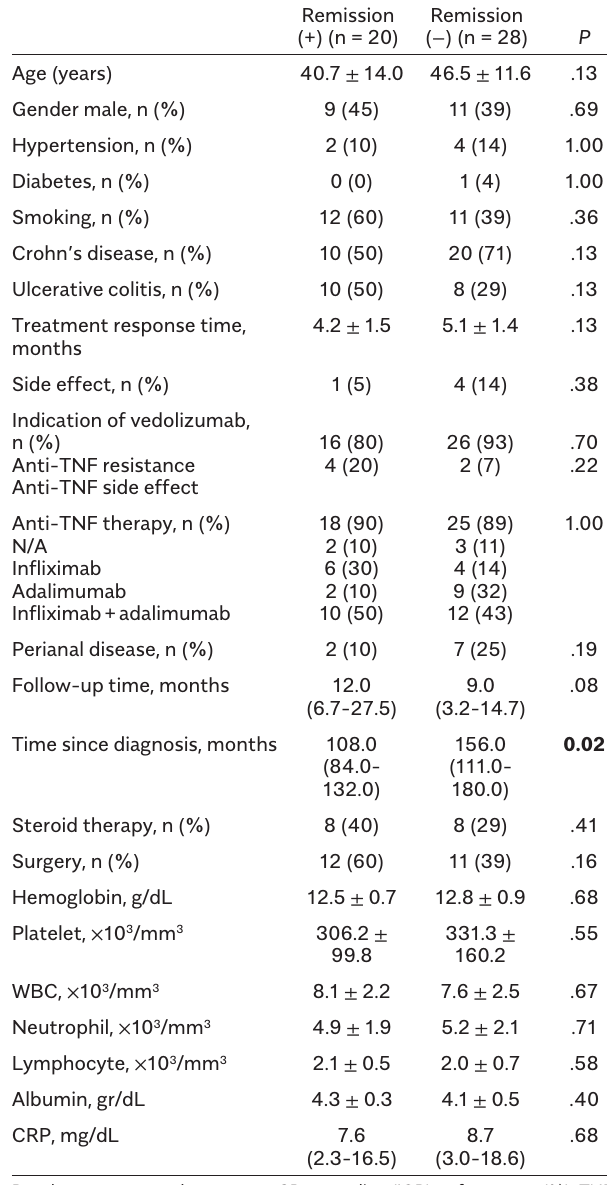
Table 4. Baseline Clinical and Laboratory Parameters According to Treatment Response